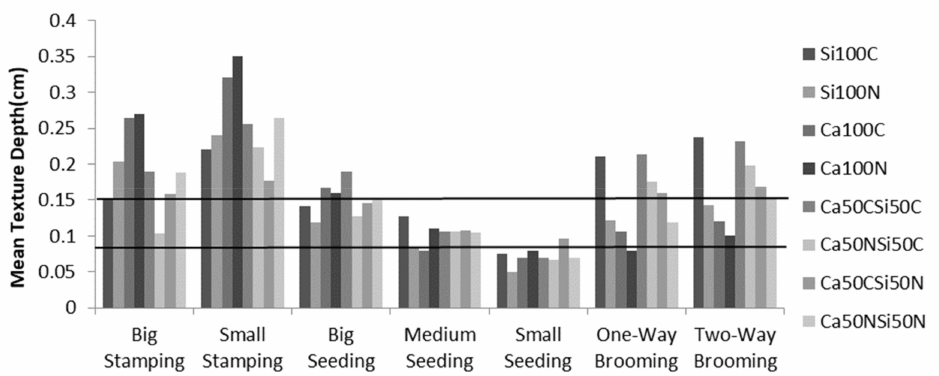
Figure 16. The MTD of different mixing proportions and different macro-textures.